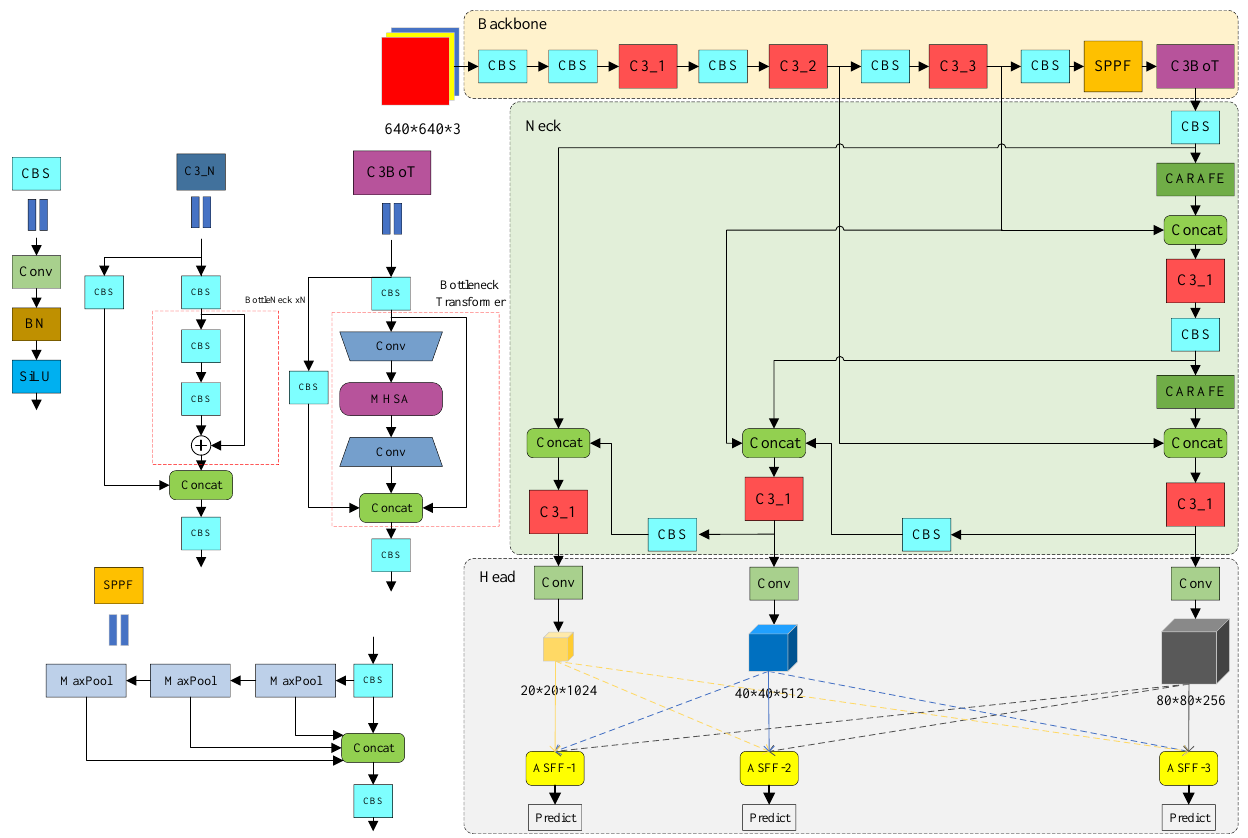
Figure 5. Structure of optimized MHSA. The attention logarithm is qr T + qk T , where q , k , r , and v represent query, key, position encoding, and value respectively. ⊕ and ⊗ denotes element-wise sum and matrix multiplication respectively, while 1 × 1 denotes point-by-point convolution.